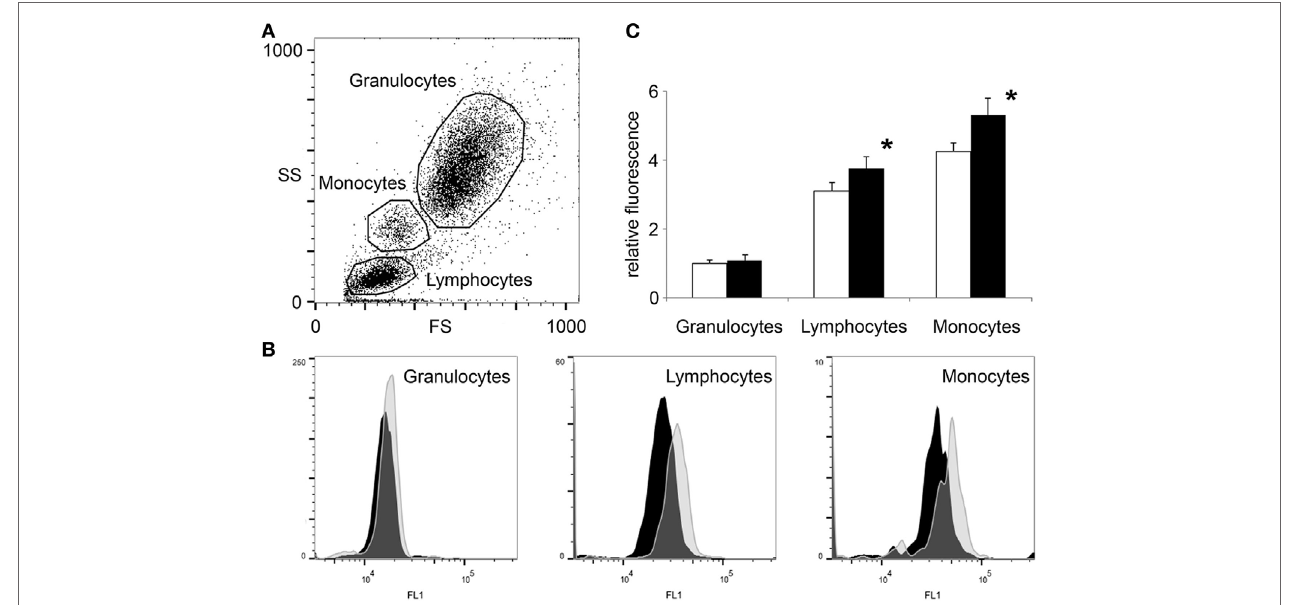
FigUre 2 | Flow cytometry shows increased O-GlcNAc levels in lymphocytes and monocytes but not in granulocytes after exercise. White blood cells were isolated from blood collected 3 h before and after a 2-mile running exercise. After labeling with anti-O-GlcNAc antibody RL2 and green fluorescent secondary antibody (detected at FL1 channel), the cells were counted by flow cytometry. (a) Data points are shown as a function of forward scatter and side scatter (FS— x -axis, SS— y -axis). Three major group of cells were selected; granulocytes, lymphocytes, and monocytes. (B) The O-GlcNAc staining (FL1 channel) of the three regions of cells were individually displayed by histograms. Distribution of cells collected before exercise are presented by black histograms, while the distribution of cells collected after exercise are presented by light gray histograms. (c) Relative FL1 fluorescence levels of O-GlcNAc labeled blood cells, collected before (open bars) and after (black bars) exercise. The mean fluorescence level of the granulocytes collected before exercise was selected for baseline. Data are shown as mean ± SD, * p < 0.05 vs before